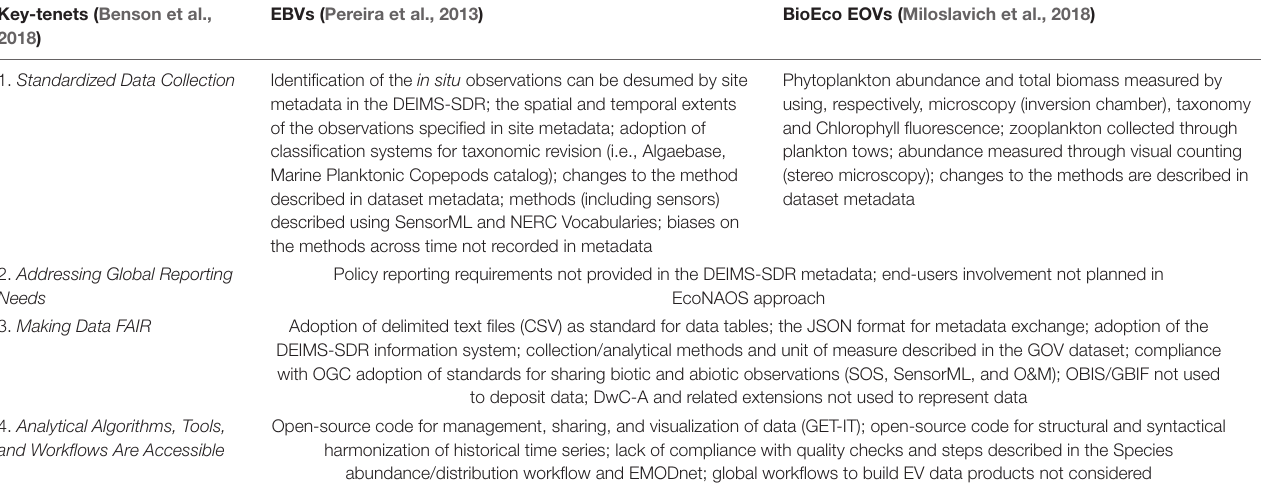
TABLE 2 | The compliance